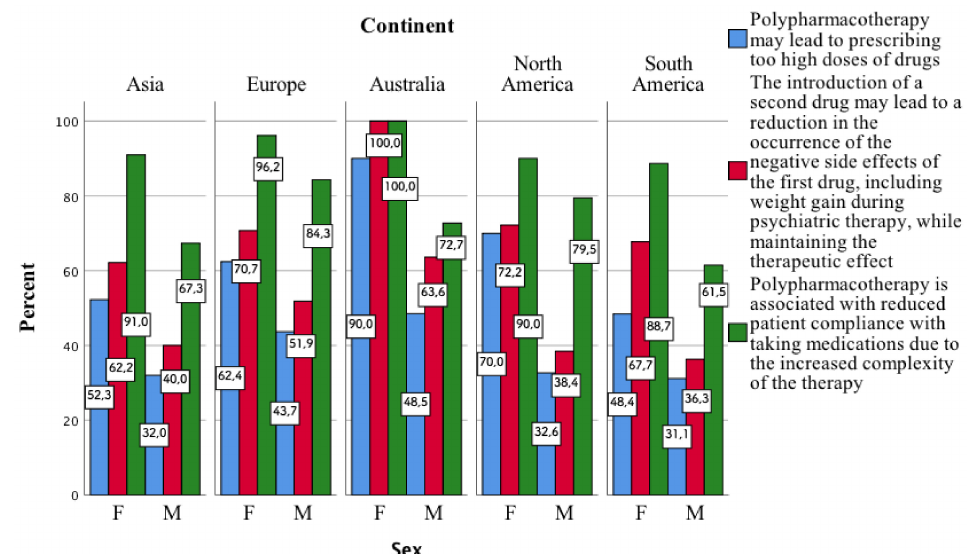
Figure 3. Opinion of the surveyed women and men on three aspects related to the risks and benefits of using polypharmacy.